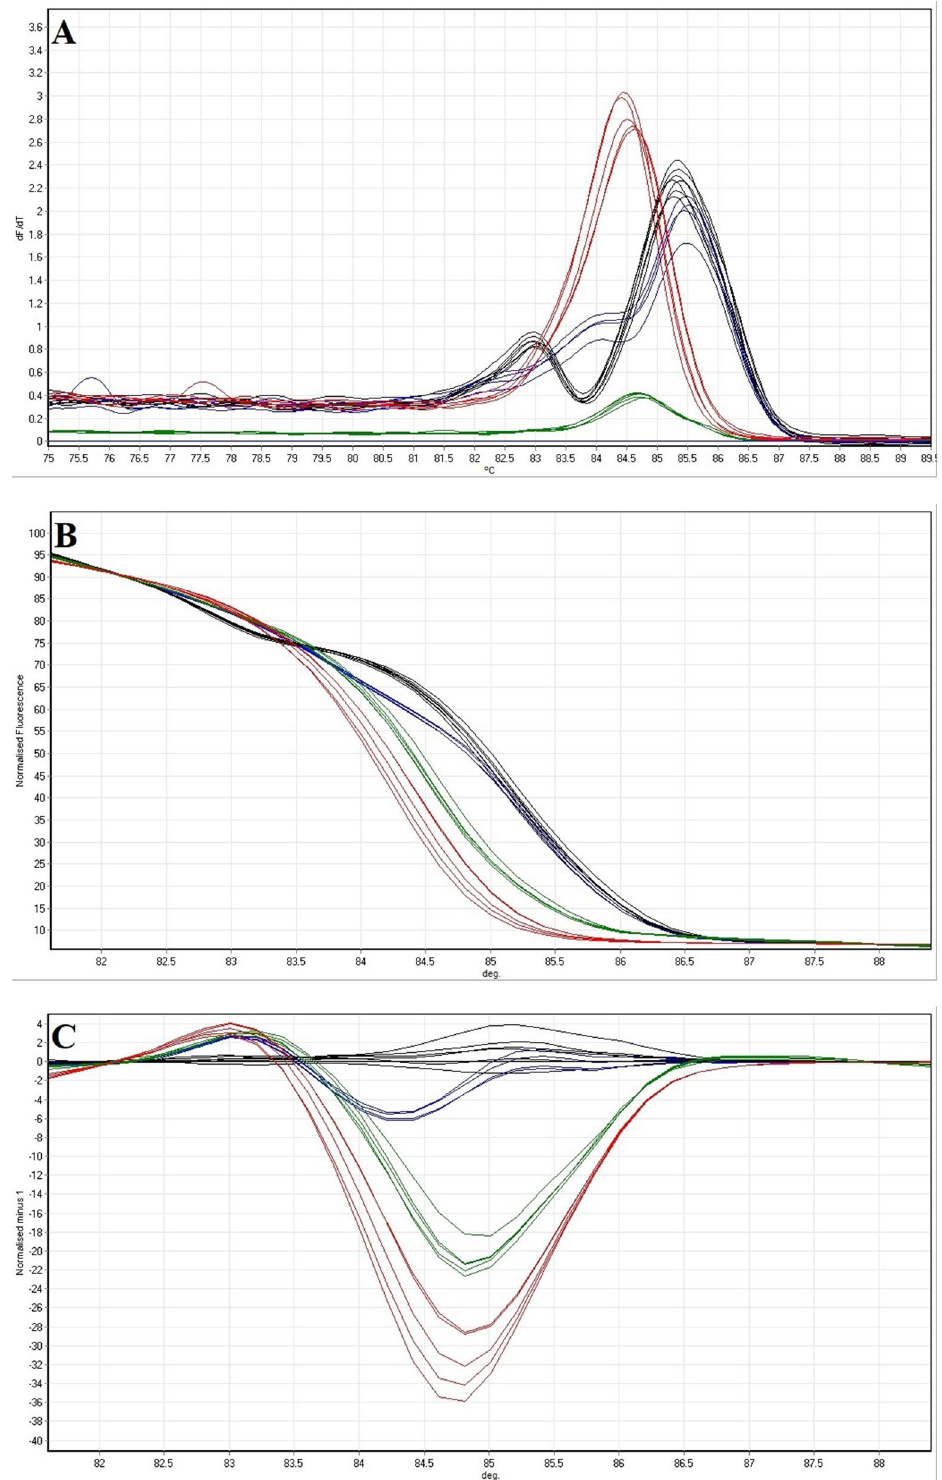
Figure 8. ( A ) Melting curves, ( B ) normalised melting curves and ( C ) difference plots the Shigella isolates from food samples analysed by PCR-HRM assay. Green curve: S. dysenteriae . Red curve: S. flexneri . Blue curve: S. boydii . Black curve: S. sonnei